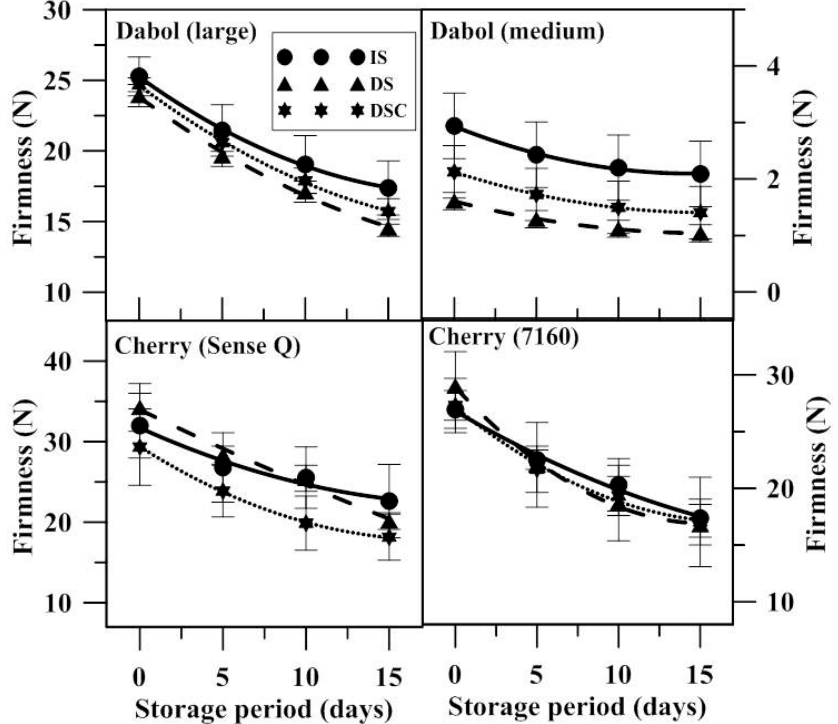
Figure 3. Changes in firmness of four tomato cultivars over 15 days of storage under IS (immediate storage), DS (storage delayed 24 h), and DSC (storage delayed 24 h under cover) postharvest treatments.